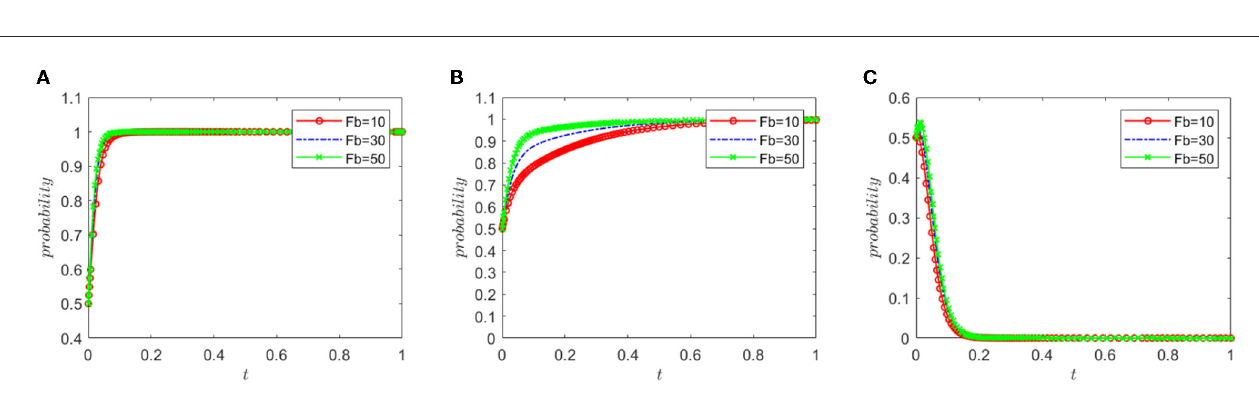
FIGURE8 The trajectory of the evolution of the strategies of the three subjects under different levels of punishment by the government to the city administration. (A) Recycling industry, (B) Urban management officer, and (C)